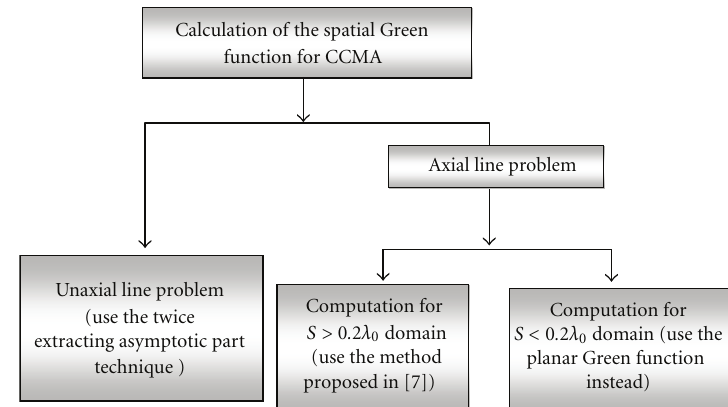
Figure 4: Calculation of the spatial Green function for MMCA.